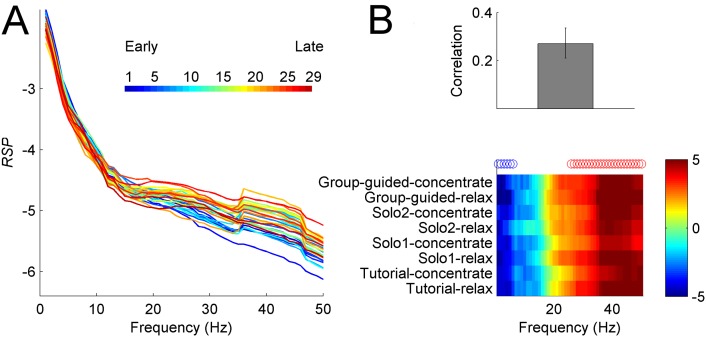
Time-of-night effect (example left frontal channel).
(A) Mean RSP curves from 29 sessions during Tutorial-relax condition. (B) Top: omnibus correlation between RSP values and time-of-night across all guided conditions. Error bar indicates 95% CI based on bootstrap resampling. Bottom: associated frequency pattern, represented with bootstrap ratios across conditions. Reliable positive (negative) bootstrap ratios are positively (negatively) correlated with time-of-night and are indicated by red (blue) circles. As the night progressed, there was as a gradual shift towards more power in high frequencies and less in low frequencies.